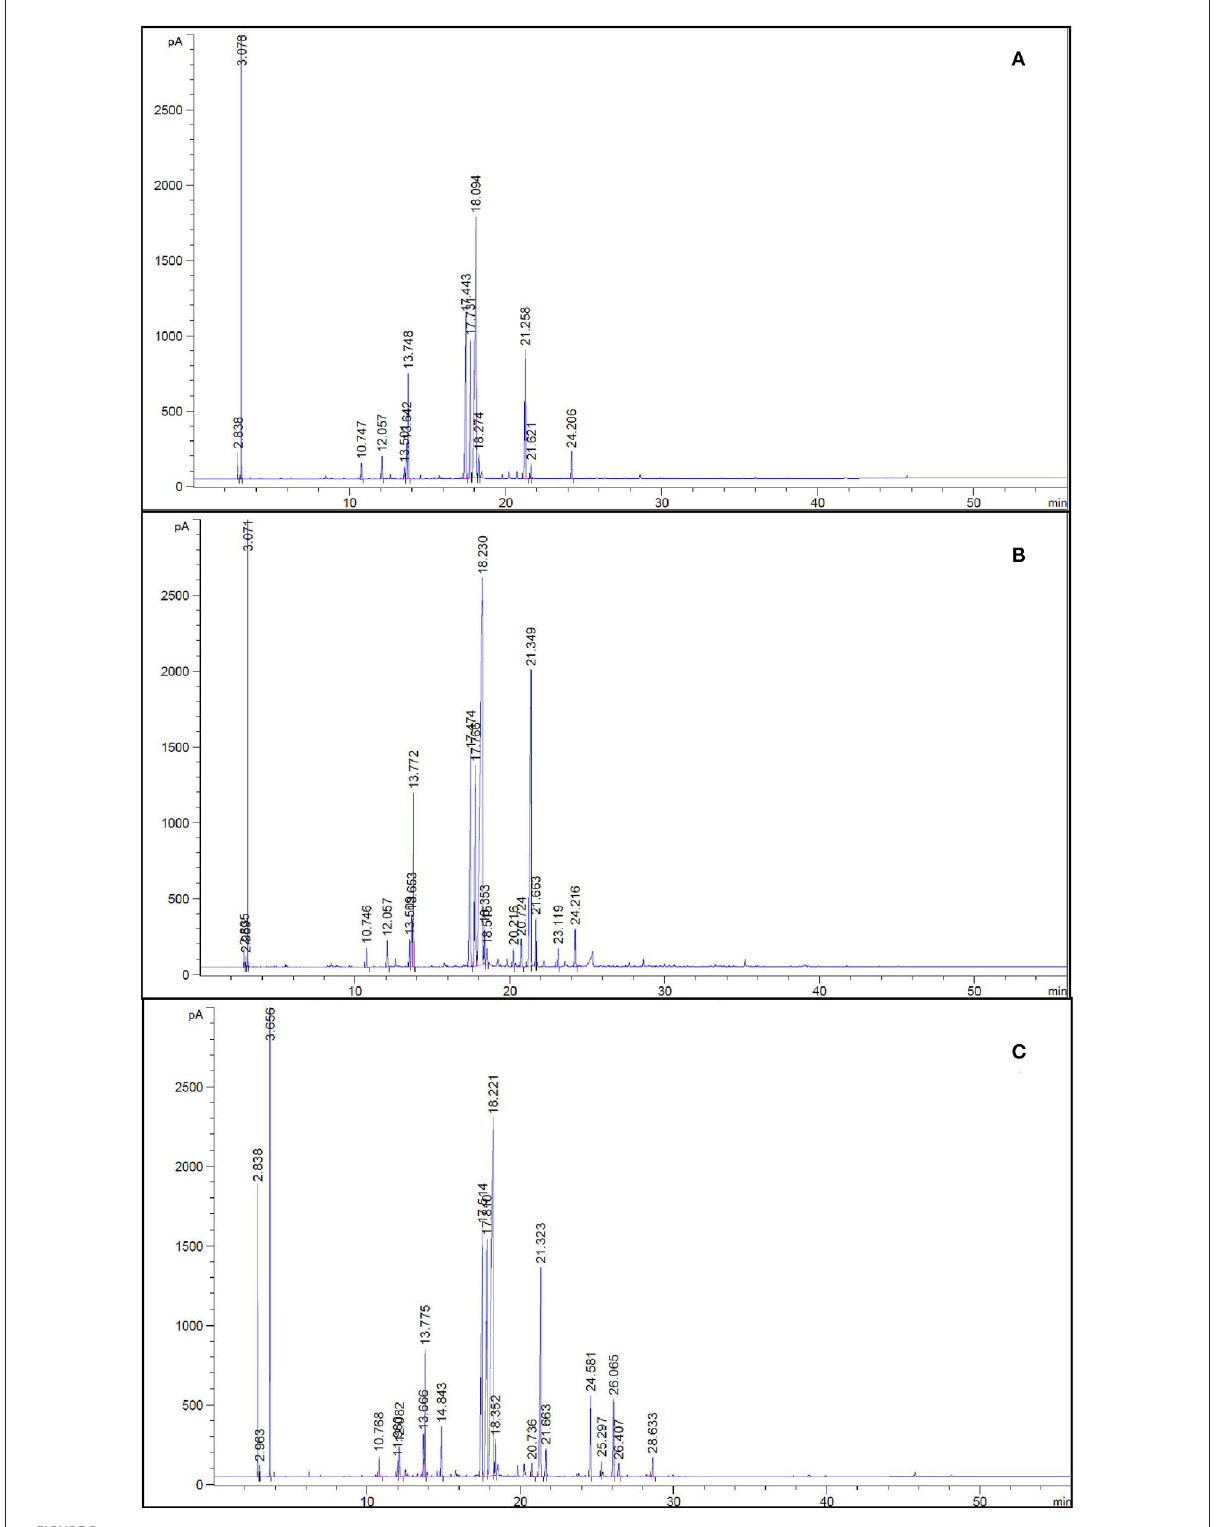
FIGURE5 GC chromatograms of control (de-ionized water) (A) , ICn-80 (B) , and As-40 + ICn (C) treatment plants displaying peaks of different active constituents of essential oil in peppermint ( Mentha piperita L.) 150 days after transplanting with/without As stress (10, 20, or 40mg kg − 1 of soil, as Na 2 HAsO 4 · 7H 2 O) and treated with ICn (80mg L − 1 ). Data are presented as treatment mean ± SE ( n =